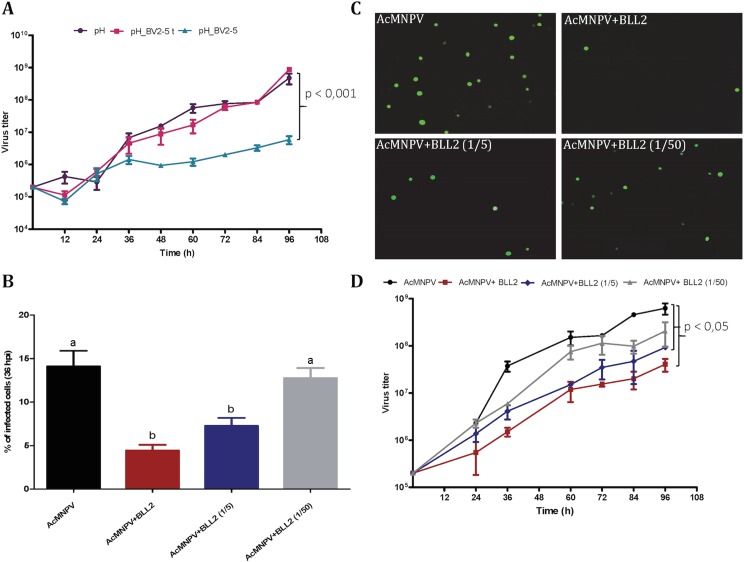

Spodoptera exigua bracovirus-like genes affect baculovirus infection.A) Effect of BV2-5 on baculovirus multiplication. One-step growth curve analysis of BV2-5 expressing virus (ph_BV2-5), virus expressing the truncated form (ph_BV2-5 t) and the control virus (ph). The results are the means ± standard deviations (error bars) for independent infection and titration experiments. BV accumulation is shown as the viral titer, calculated for each time point. Statistically different curves and P-Values (Dunnett’s test) are indicated by square brackets. B, C, D) Effect of Se-BLL2 on baculovirus infectivity. AcMNPV-GFP virions were preincubated with different concentrations of purified recombinant Se-BLL2 (50 μg/mL, 10 μg/mL, and 1μg/mL) and then used for the infection of Sf21 cells. B) Percentage of Sf21 cells infected with baculovirus (GFP positive) 36 hours after infection C) Representative images of the infected cells 36 hours after infection. D) One-step growth curve analysis of baculovirus in presence of BLL2. Statistically different curves (Dunnett’s test) are indicated by square brackets.